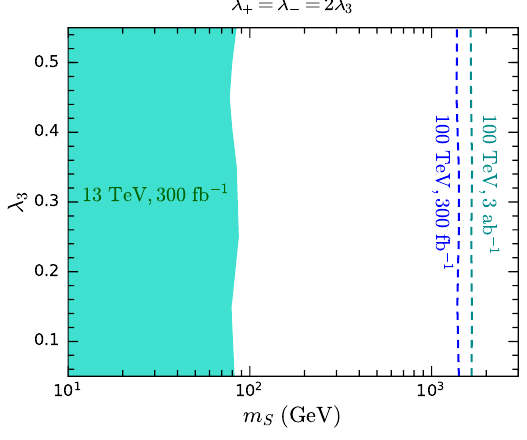
Figure 6 . Current constraint and future sensitivity of the monojet + /E plane for λ + = λ − = 2 λ 3 . The turquoise region is excluded at 95% C.L. by the 13 TeV ATLAS monojet + /E search with a dataset of 36 . 1 fb − 1 [83]. The blue and purple dashed lines denote T